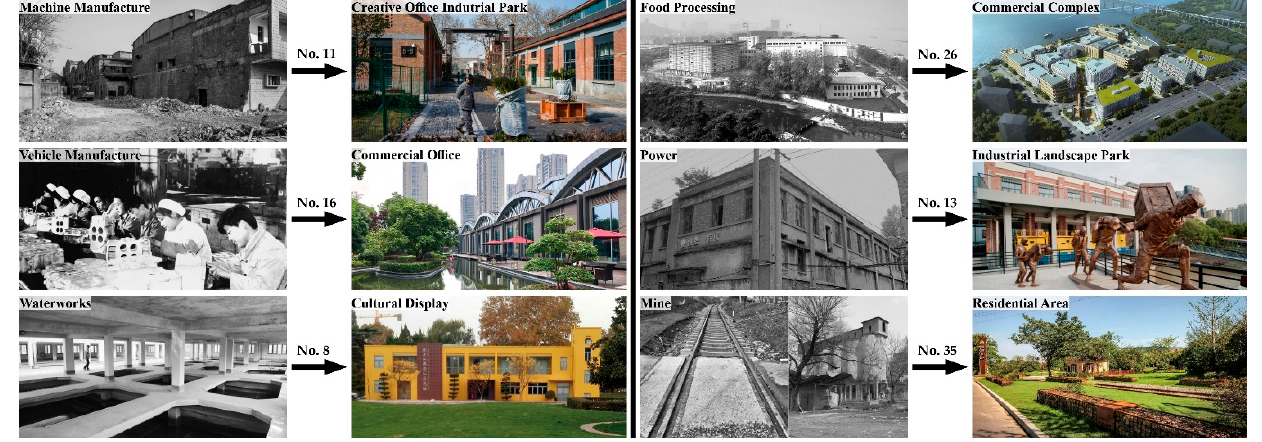
Figure 33. Typical cases of six reuse purposes of industrial heritage sites in Nanjing (Figure source: Zhou Qi Studio and on-site investigation). (The numbers in this figure represent the locations of these industrial sites in the maps above.)